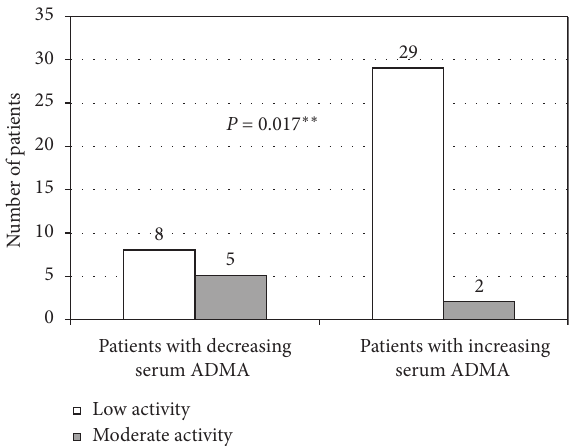
Figure 3: Basal activity level at the start of the Table 3: Statistical correlations of serum ADMA (before and after exercise) and serum ADMA change. S. ADMA before S. ADMA after S. ADMA change exercise